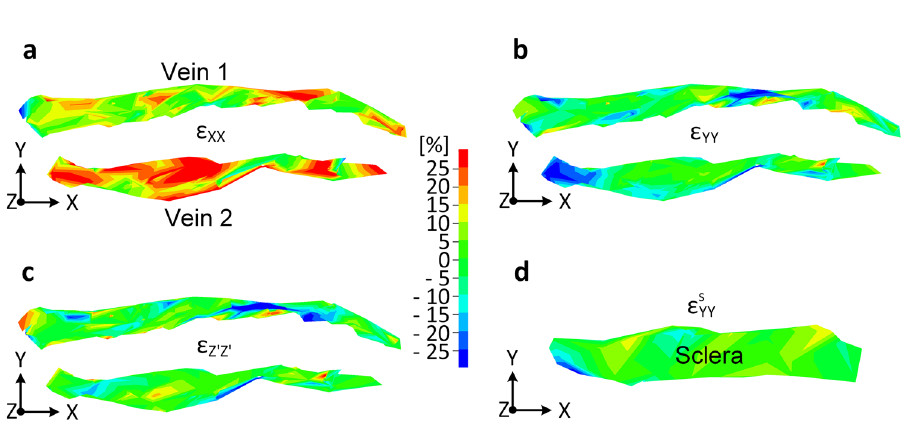
Figure 4. Spatial variation of normal strains at 20 mmHg. ( a ) 𝜀 XX , ( b ) 𝜀 YY , and ( c ) 𝜀 Z’Z’ of the aqueous veins 1 and 2, and ( d ) estimate of 𝜀 s YY of tissue between the two aqueous veins. (Generated using LS-Dyna R9.0, http:// www. lstc. com/ produ cts/ ls-